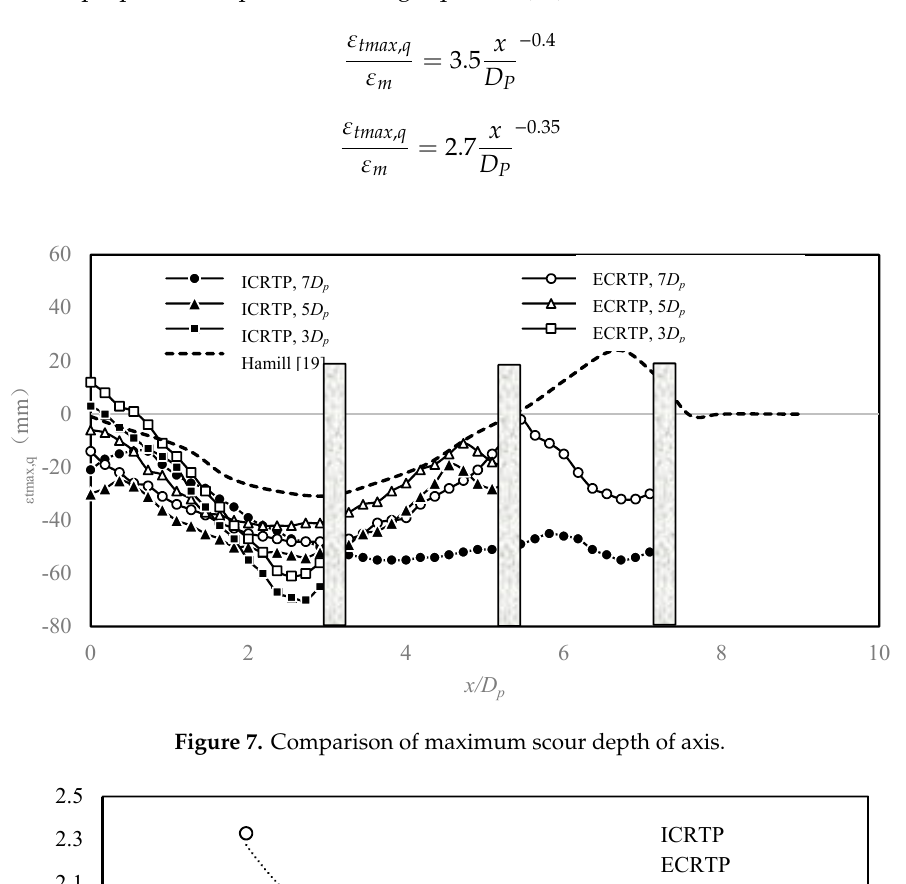
Figure 7. Comparison of maximum scour depth of axis.